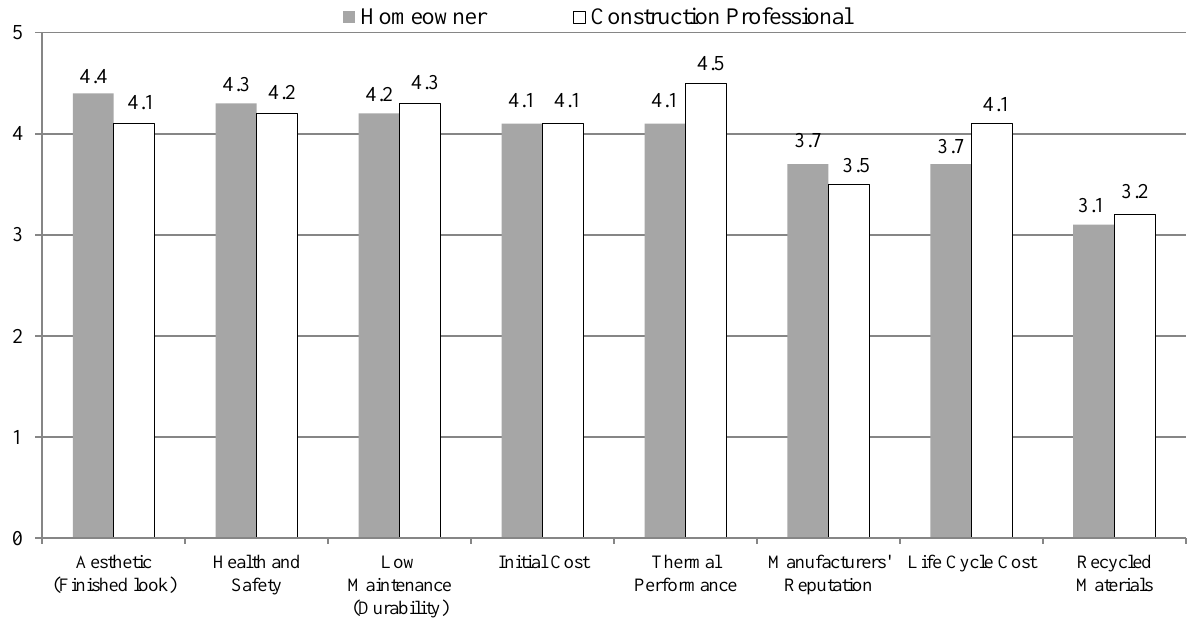
Figure 4. Decision making factor for refurbishment materials (Likert scale from 5—“Very Important” to 0—“Not Considered”).